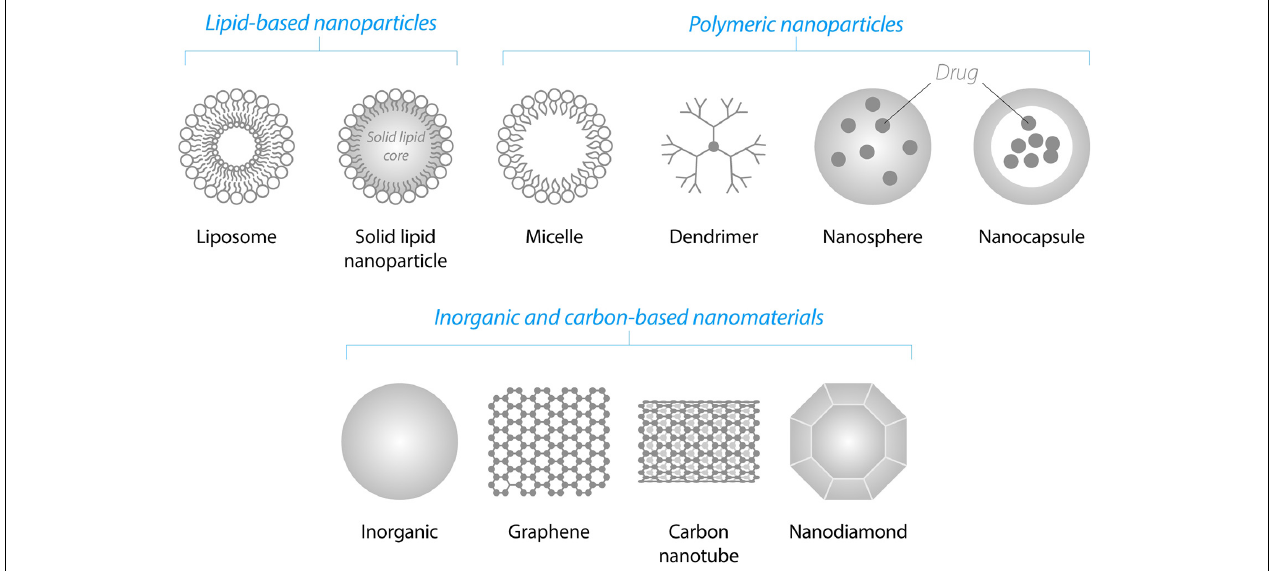
FIGURE 4 | Schematic illustration of various classes of NPs suitable for the delivery of NTFs through the blood–brain barrier.